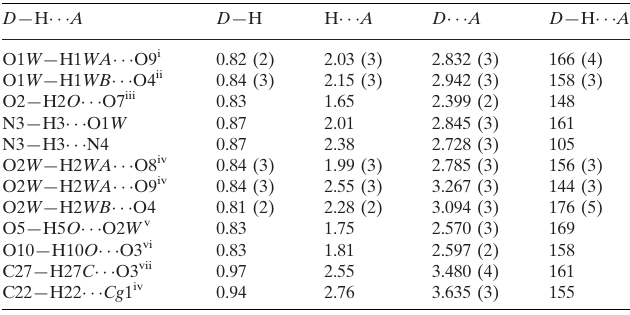
Hydrogen-bond geometry (A˚ , (cid:4) ). Cg 1 is the centroid of the